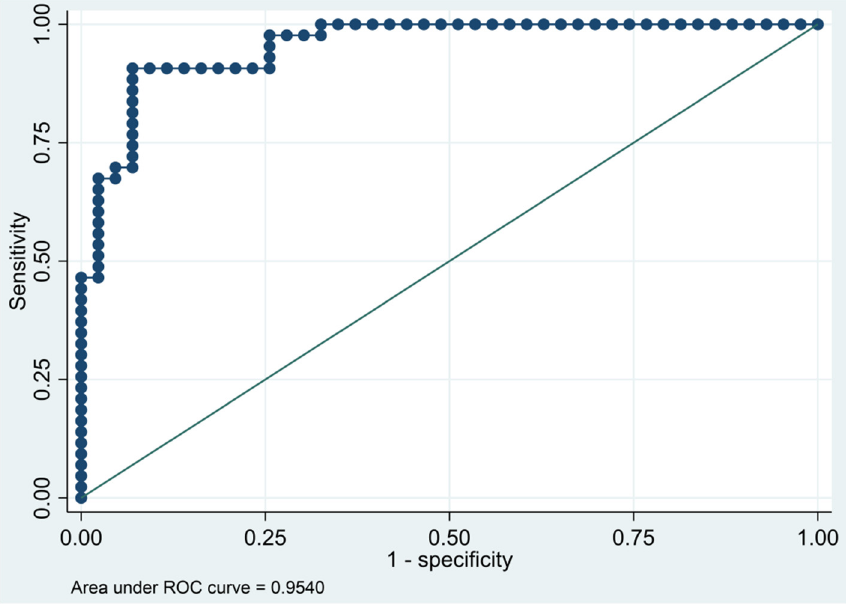
Figure 2. Receiver operating characteristics curve of the final multivariate logistic regression model based on cytokines from the immune-oncology panel.